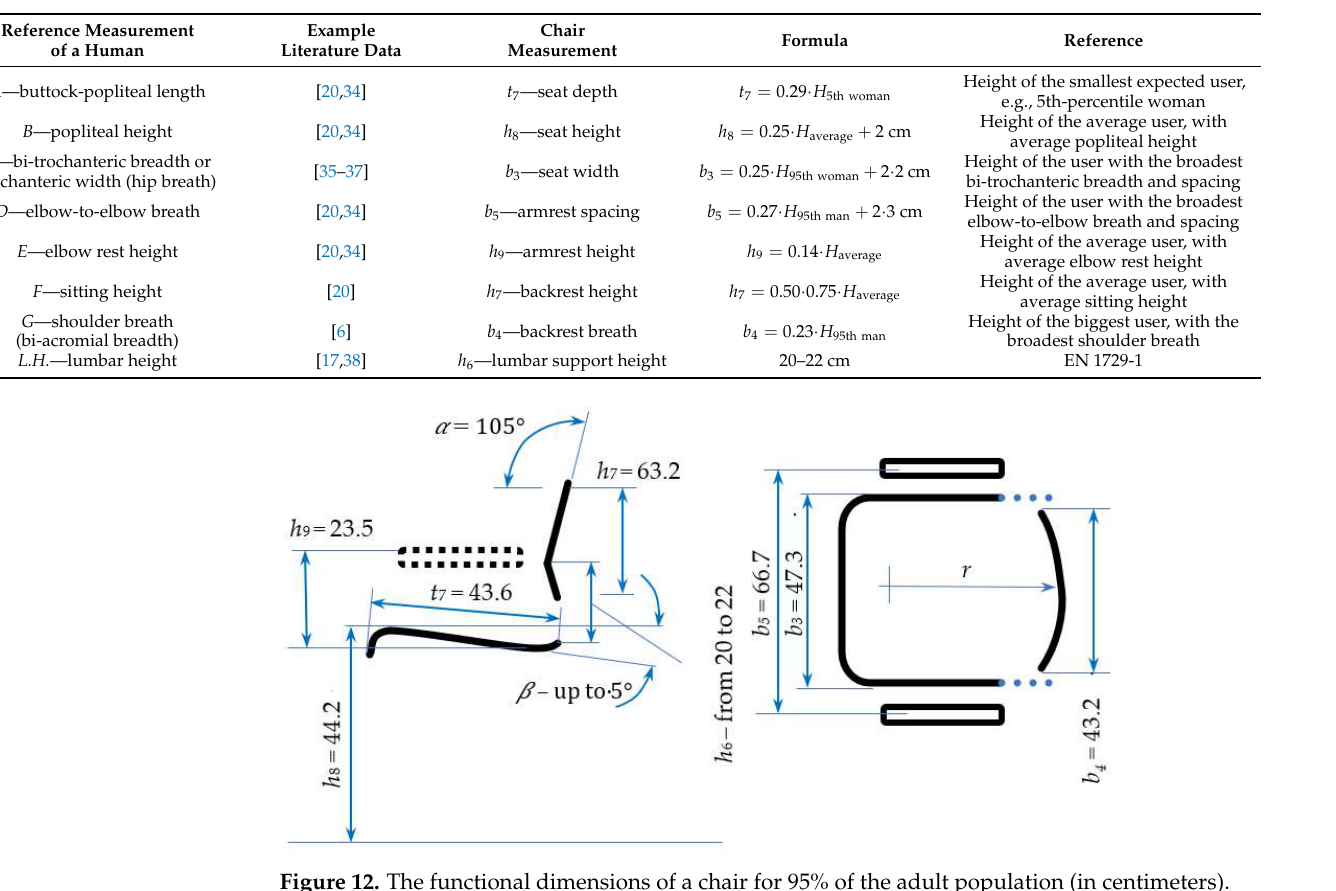
Figure 12. The functional dimensions of a chair for 95% of the adult population (in centimeters).